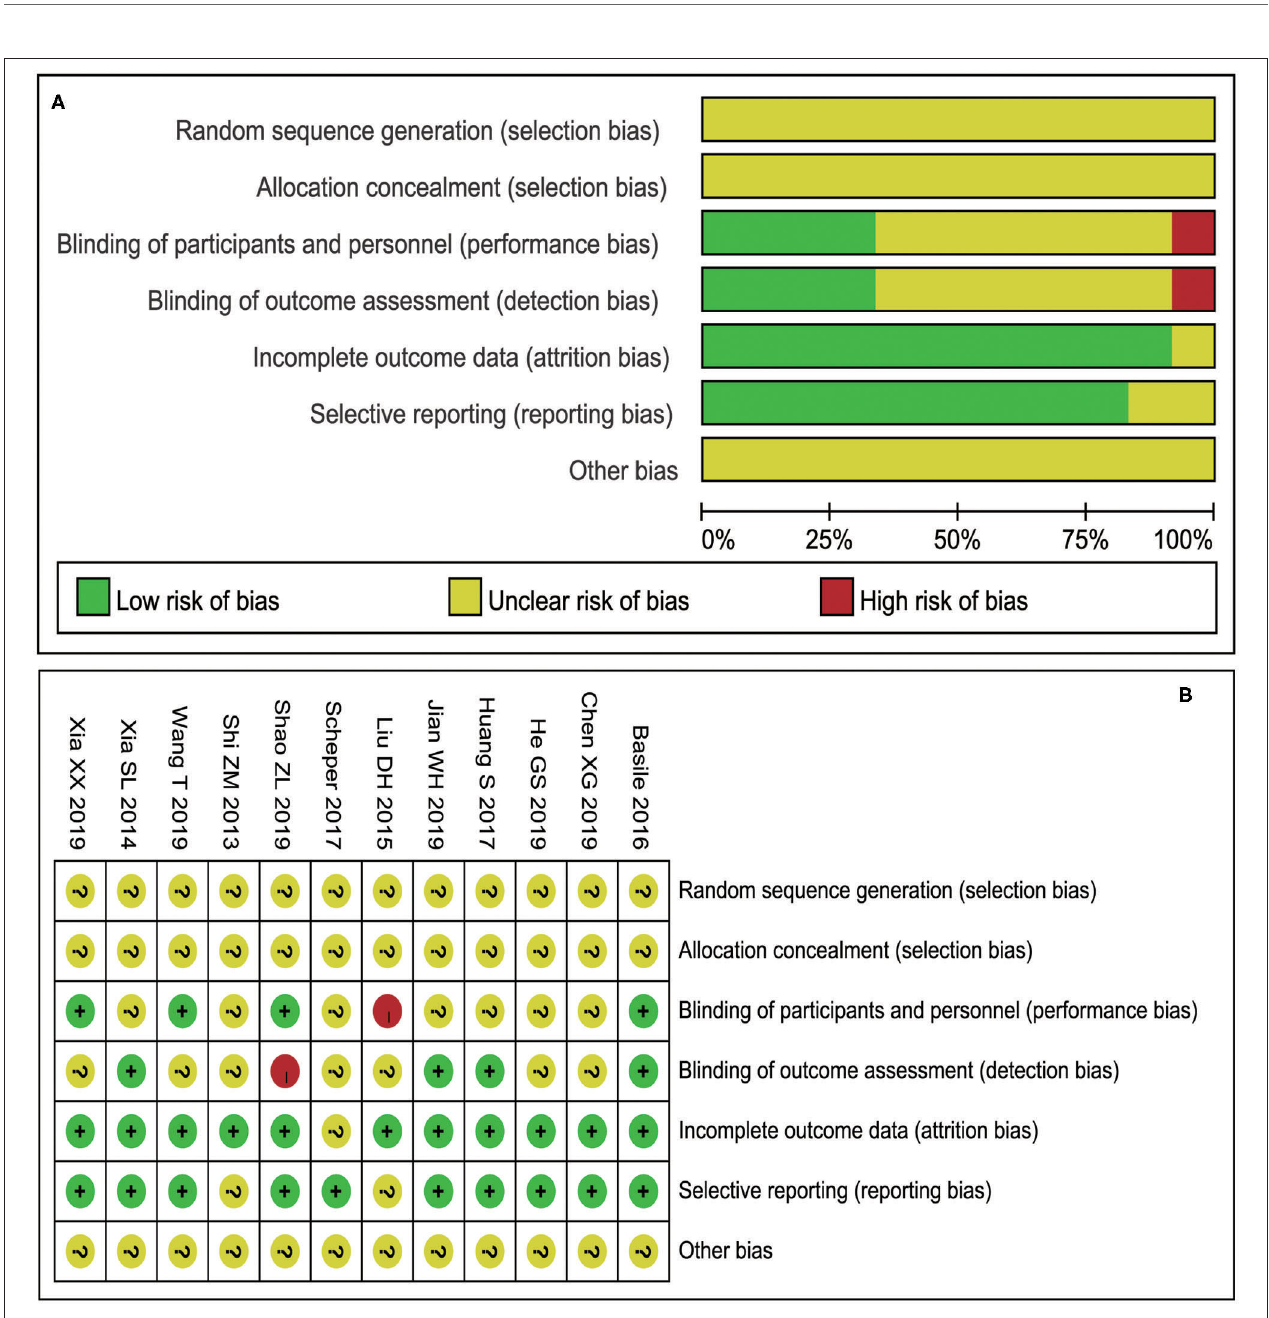
FIGURE 2 | Risk assessment results included in the study ( A : Risk of bias graph; B : Risk of bias